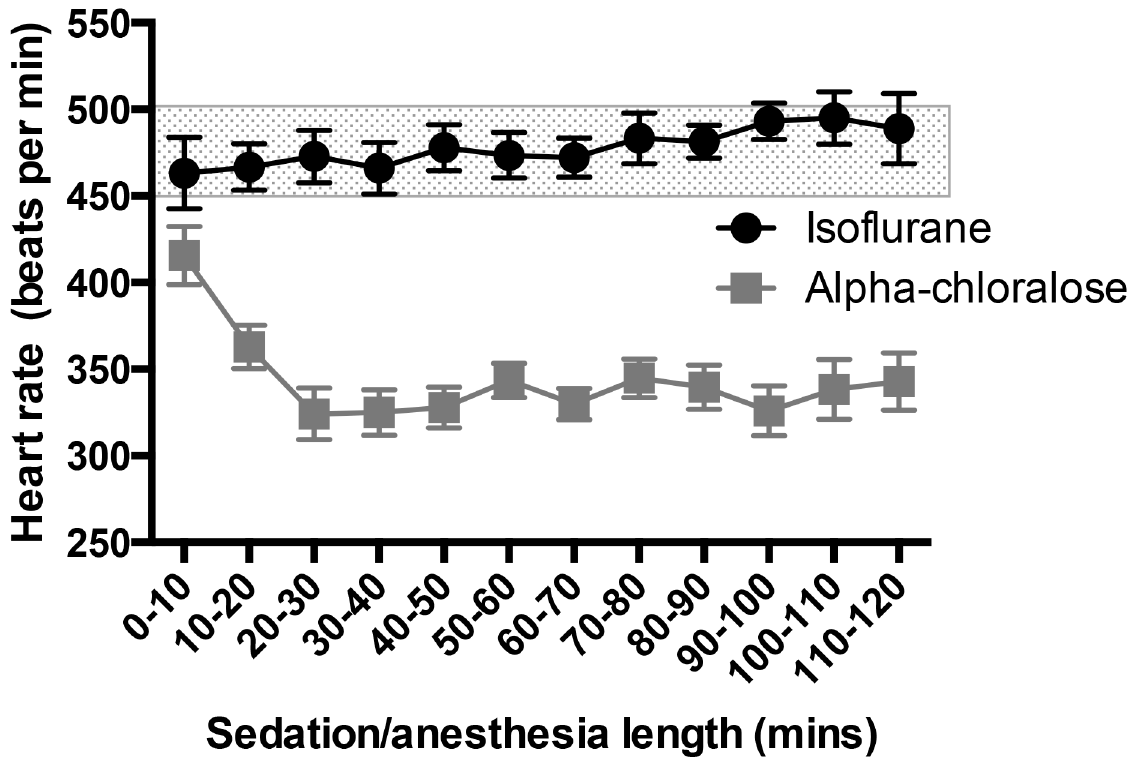
Fig 2. Heart Rate drops under alpha chloralose sedation. Mice retain a steady heart rate under isoflurane anesthesia, ranging from 463 ± 20 beats/min to 489 ± 20 beats/min. However, under alpha chloralose sedation, heart rate rapidly drops to below 350 beats/min, leading to a significant difference in heart rate between the treatment groups (F (1,384) = 516.2,p < 0.0001, n = 9 – 23 per time point). The shaded region indicates the normal heart rate for an awake mouse at rest (450 – 500 beats/min).